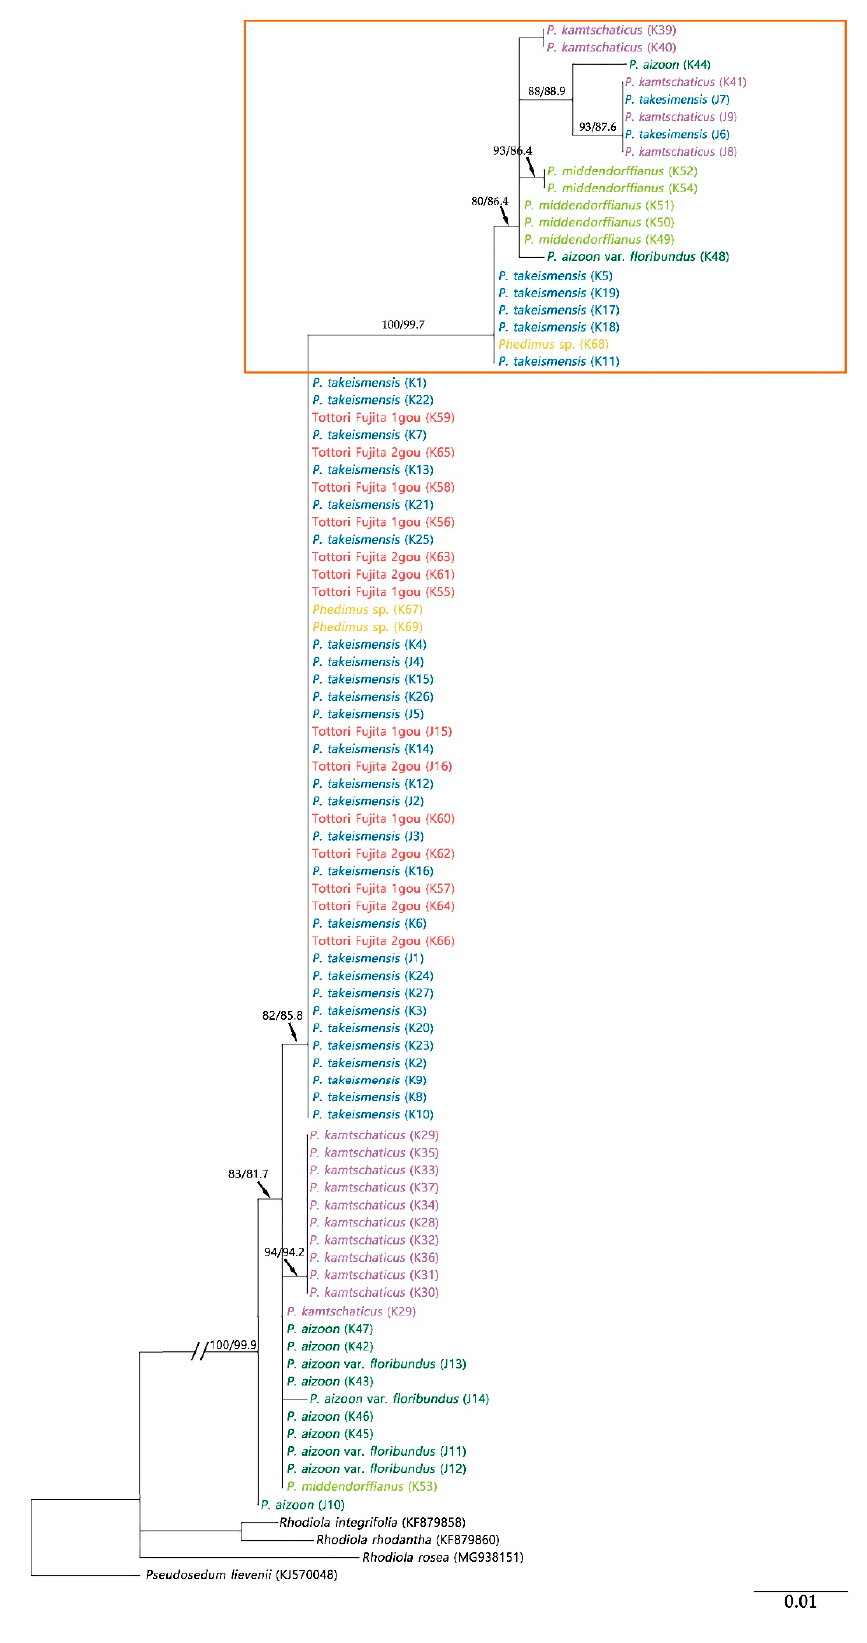
Figure 4. ML tree of the genus Phedimus using psb A- trn H sequence without correcting for the inversion. Numbers on branches indicate the bootstrap values and SH-aLRT support.